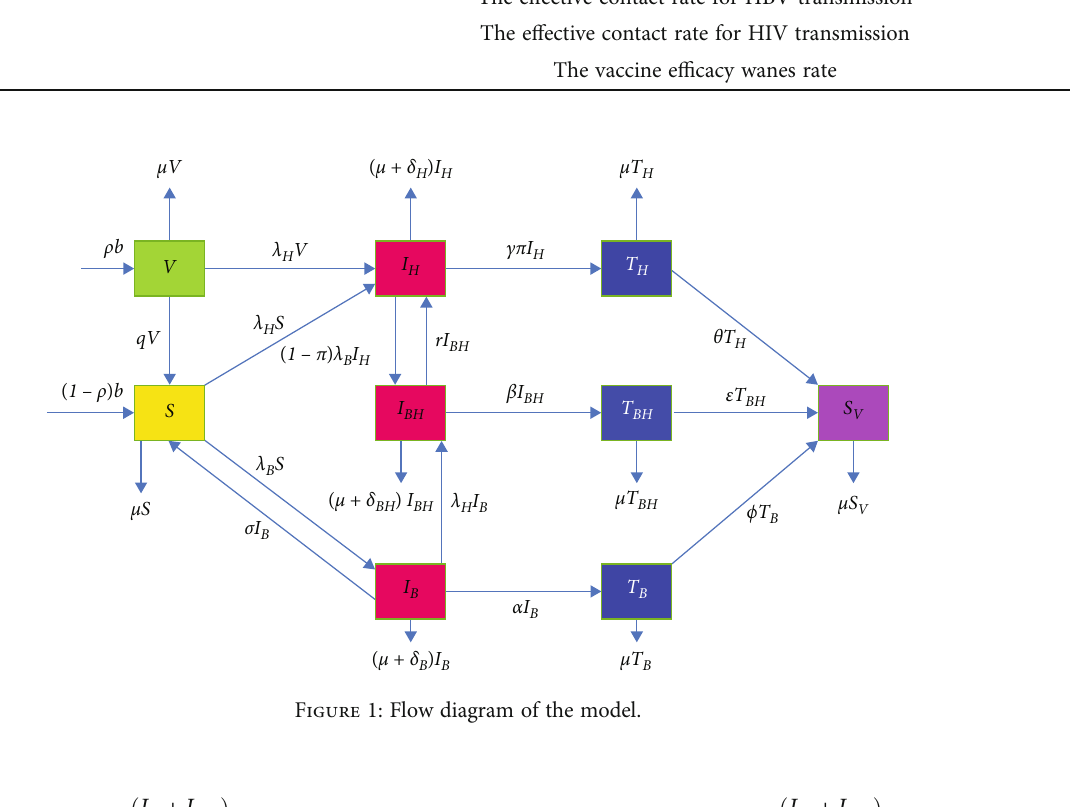
Figure 1: Flow diagram of the